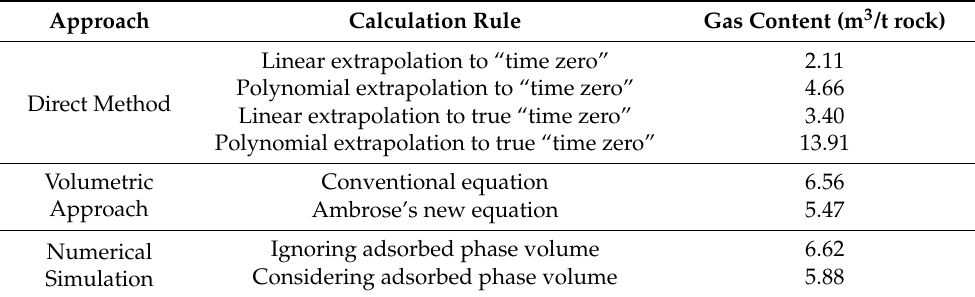
Table 1. Total GIP results derived from different